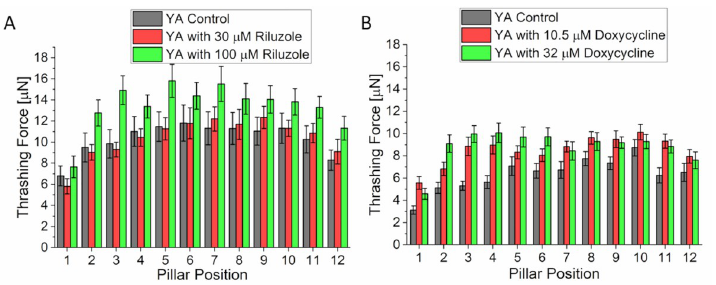
Fig 4. Thrashing force assay in ALS model worm (AM725). (A) Mutant worms treated with 30 μ M riluzole did not show any significant change in thrashing force compared to untreated worms (p > 0.05). When the concentration of riluzole was increased to 100 μ M, there was a significant increase in the measured thrashing force compared to control worms which were not treated with any drug (N = 25, p < 0.001). (B) Treatment with either 10.5 μ M or 32 μ M of doxycycline significantly improved the thrashing force of AM725 worm compared to control worms (N = 27, p < 0.0001). However, there was no significant difference in the thrashing force at the two different concentrations of doxycycline. Significant differences were analyzed using the two-way ANOVA with Tukey’s multiple comparison between average force values of control and treated worms, error bars indicate s.e.m. https://doi.org/10.1371/journal.pone.0246496.g004 comparison, the force analysis (Fig 4A) did not show any significant difference between con- trol and 30 μ M. In terms of the aggregate average size, there was a decrease for both concentra- tions from 55 ± 2.8 to 50 ± 2.1 and 43 ± 3.1, respectively, but only 32 μ M doxycycline decreased significantly (Fig 5E). Doxycycline treatment significantly decreased the average count for treatments with 10.5 μ M and 32 μ M from 21 ± 0.77 to 19 ± 0.67 and 17 ± 0.65, respectively. For the average area there was no significant decrease for 10.5 μ M while treatment with 32 μ M doxycycline showed a significant decrease in the average area.